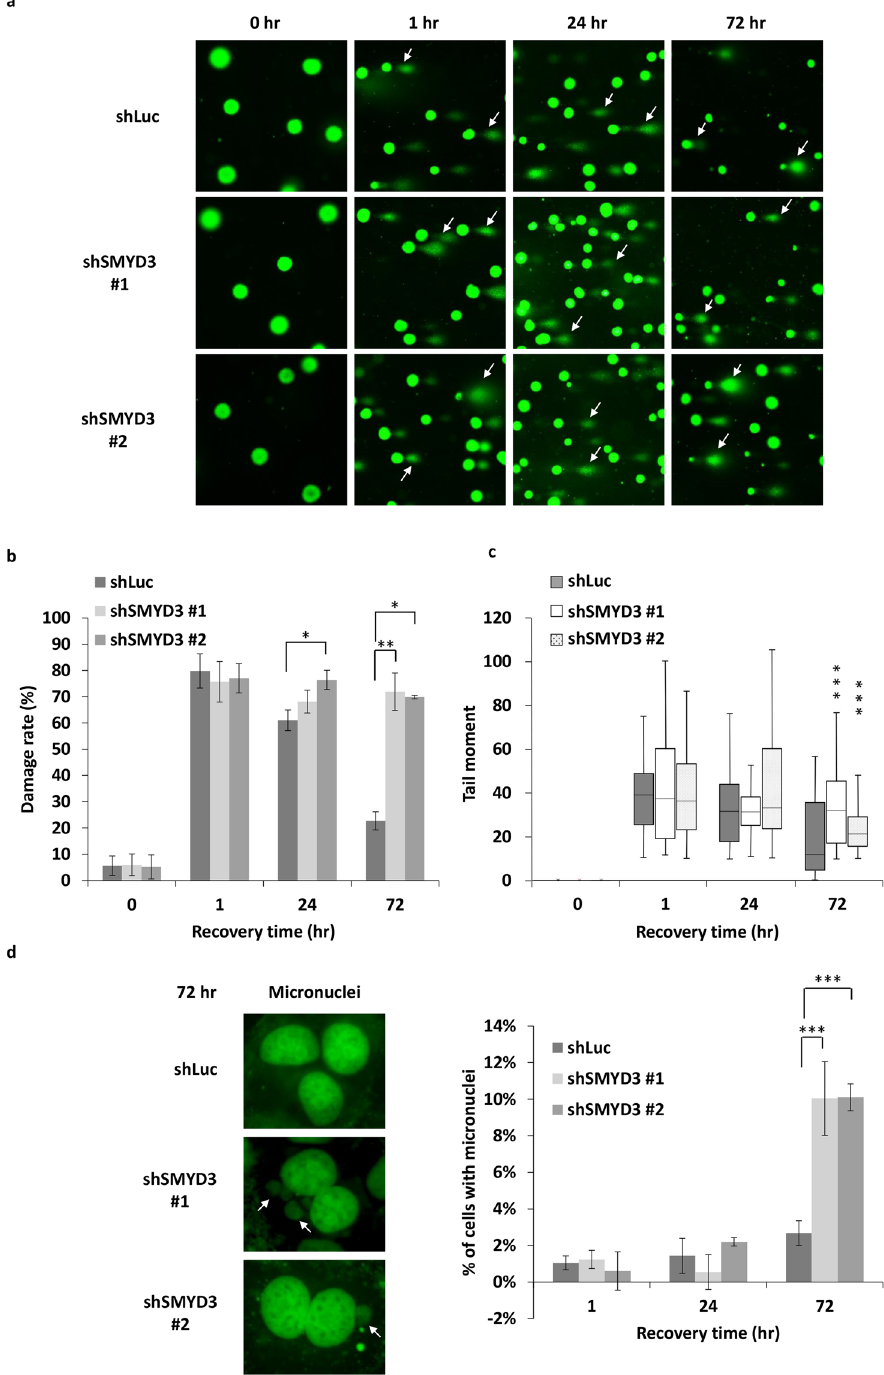
Figure 2. SMYD3 deficiency causes genome instability. ( a , b ) shLuc and shSMYD3 MCF7 cells were treated with 1.67 Gy IR and then analysed for DNA damage by comet assay at indicated times. ( a ) Representative images with white arrows point to comet tails, which signify DNA damage. ( b ) Quantification of the percentage of nuclei with comet tails. ( c ) Quantification of comet tail moment using the CometScore software. Data are presented as a quantile box plot. The middle lines in boxes indicate the median; upper and lower box edges indicate the 25th and 75th percentiles; and bars indicate the 10th and 90th percentiles. Statistical analysis was performed by one-way analysis variance (ANOVA). *** P < 0.001. ( d ) Right panel, representative images of micronuclei in shLuc and shSMYD3 MCF7 cells treated with 1.67 Gy IR and recovered for 72 h. White arrows point to micronuclei, which signify aberrant chromosomal segregation. Left panel, quantification of micronuclei at indicated times. *** P < 0.001. A minimum of 100 cells per treatment group were analysed for each quantification. All values in the diagrams were means ± SD of triplicates and data were representative of n ≥ 3 for each